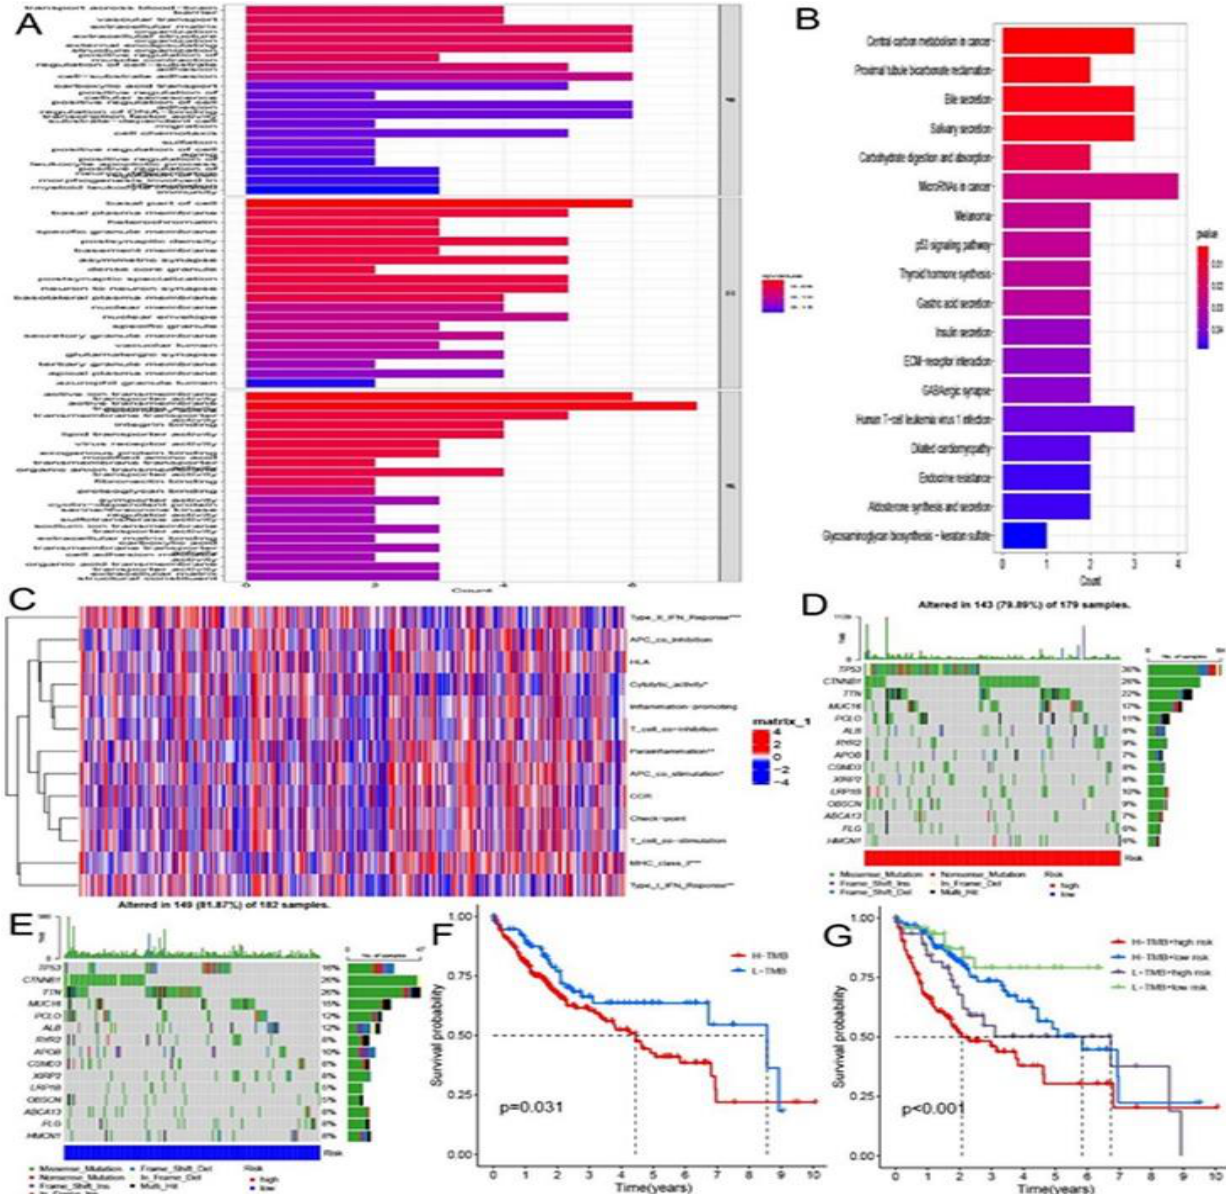
Figure 4: (A) GO enrichment analysis based on differential genes between high and low risk groups. (B) KEGG enrichment analysis based on differential genes between high and low risk groups. (C) 6 immune functions with differential expression in high and low risk groups. (D, E) Waterfall plots of somatic mutation signatures established with high and low risk scores. Each column represents an individual patient. The bar graph above shows TMB, and the numbers on the right represent the mutation frequency for each gene. The bar graph on the right shows the proportion of each variant type. (F) Kaplan-Meier survival curve of patient survival in high and low tumor mutation groups. (G) Kaplan-Meier survival curves of combined survival analysis of tumor mutational burden and risk